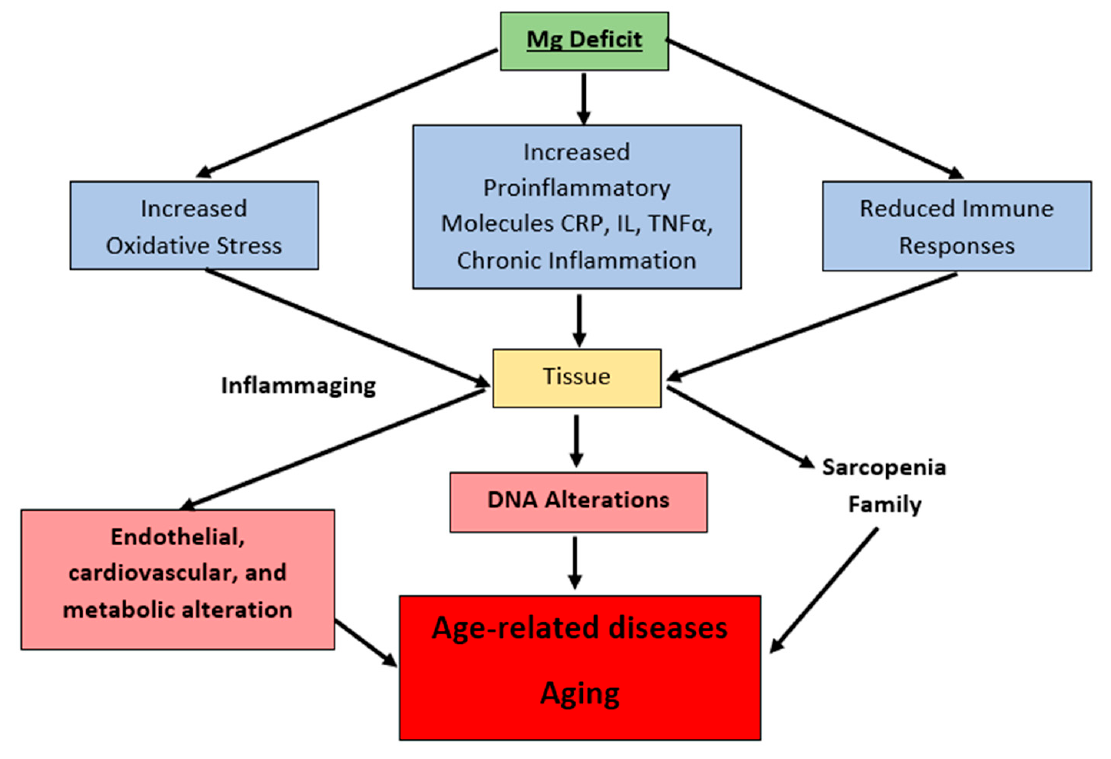
Figure 7. Effect of magnesium deficient states on age related diseases [49].